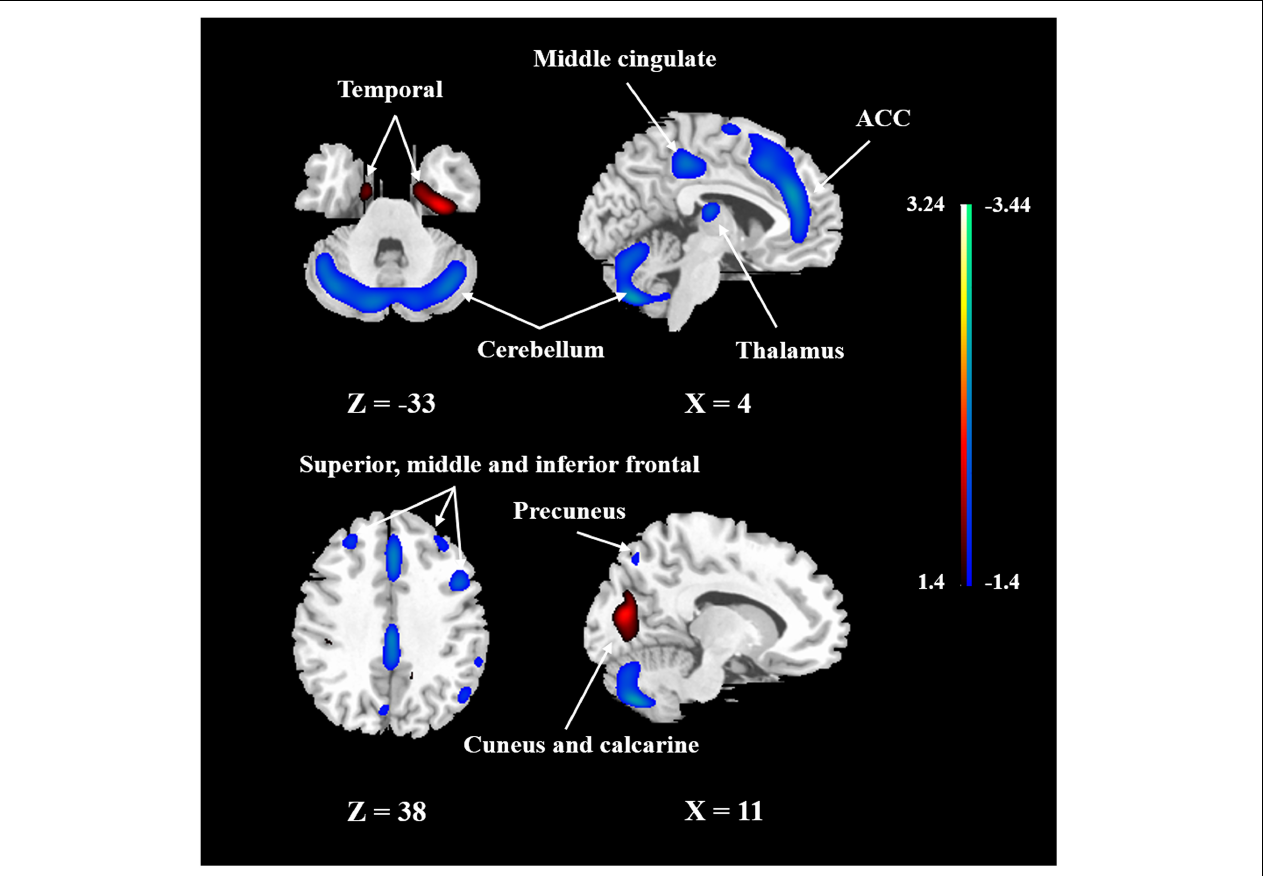
FIGURE 3 | The network of CBF changes with aging identified by SSM/PCA from 50 healthy subjects. Cold color indicates regions loading negatively correlated with age, and warm color indicates regions loading positively correlated with age. The pattern was overlaid onto a standard MRI brain template to display voxels that were reliable at P < 0.05 based on the bootstrapping algorithm. ACC, anterior cingulate gyrus.